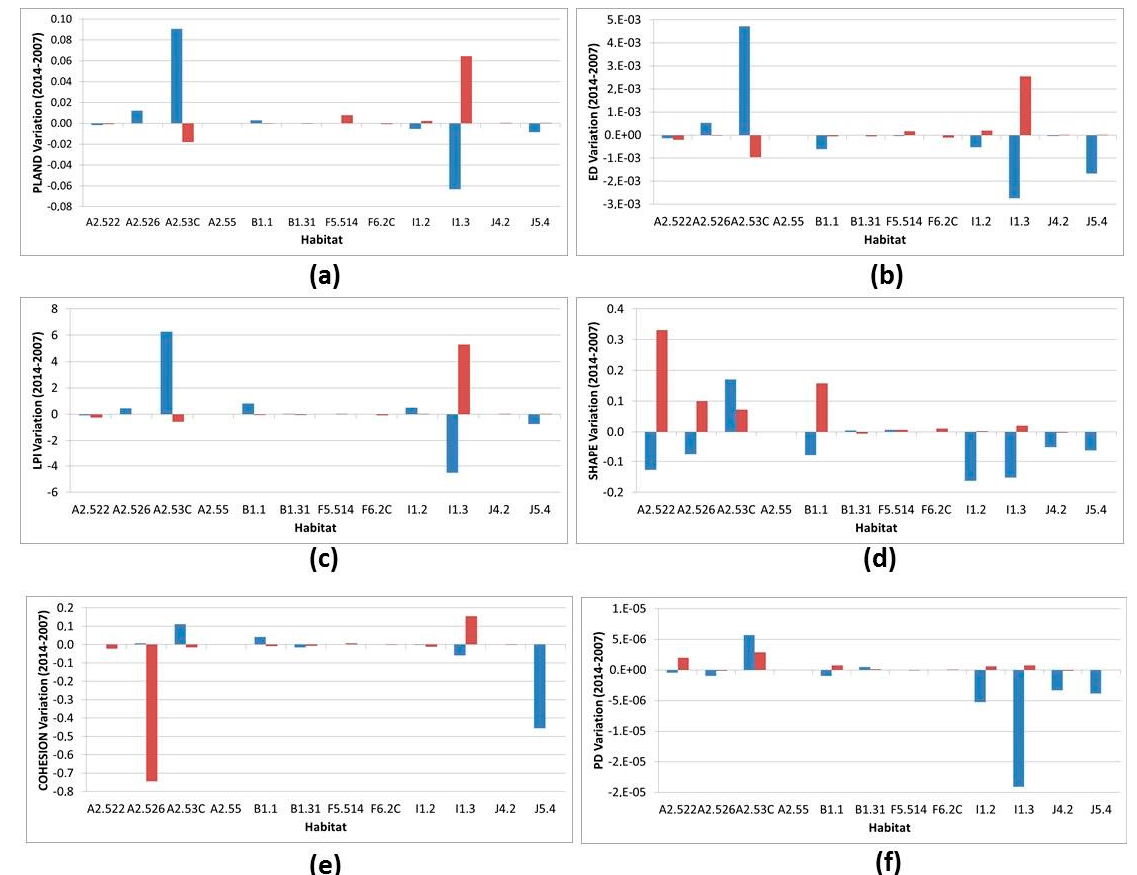
Figure 16. Barplots comparing the MCs of landscape metrics (( a ) PLAND; ( b ) ED; ( c ) LPI; ( d ) SHAPE; ( e ) COHESION; ( f ) PD) for common EUNIS classes in the two sites SC (blue) and CE